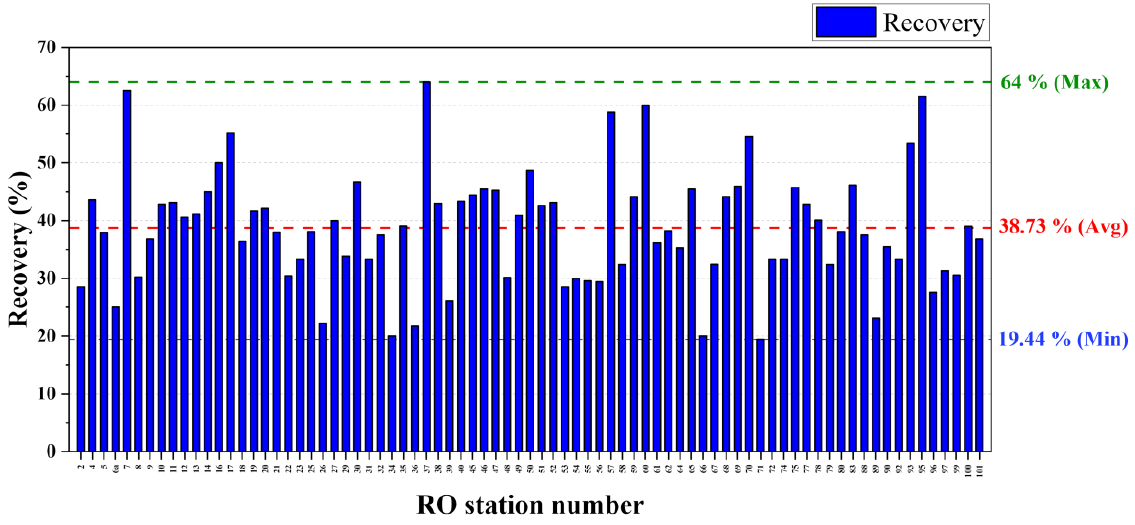
Figure 2. Permeate recovery rates of each RO stations in NCP.